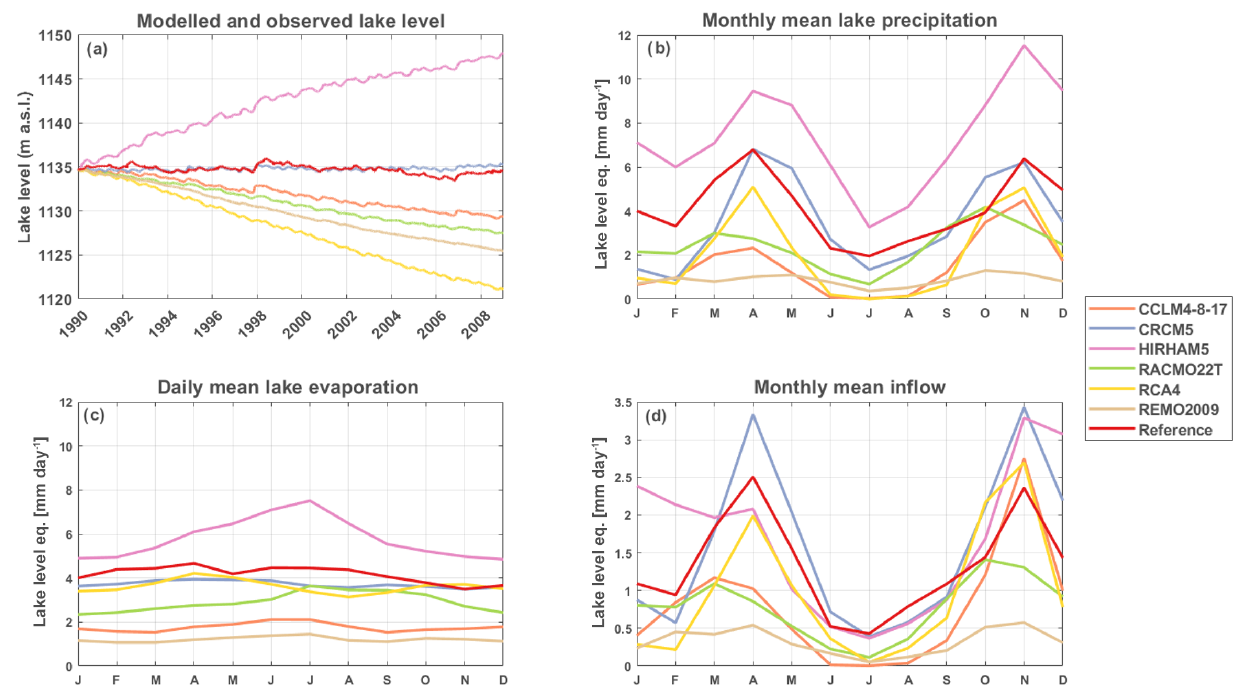
Figure 5. Modelled lake levels (a) , seasonal precipitation (b) , evaporation (c) and inflow (d) according to the CORDEX evaluation simula- tions without bias correction. Note the different y axis